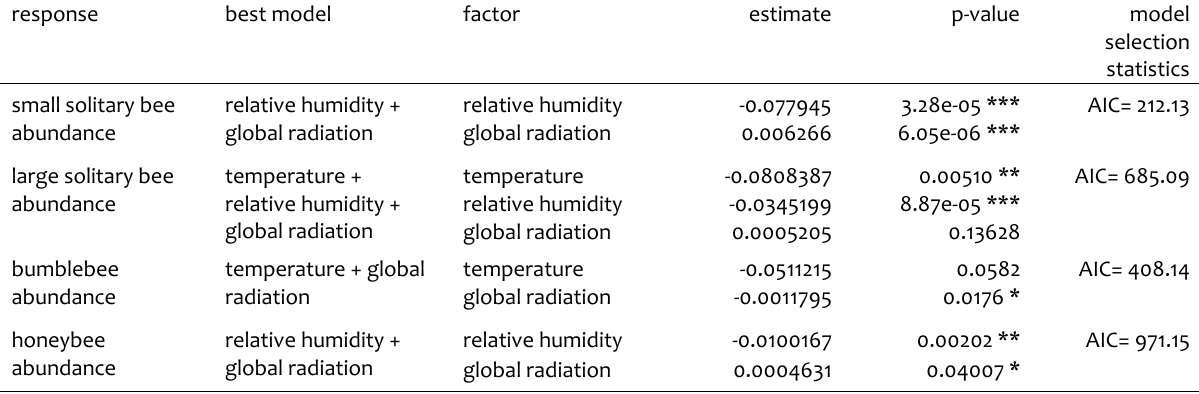
Table 10. Results of poisson regression models assessing the effect of temperature at 2 m elevation, relative humidity, and global radiation on the abundance of different bee groups on fruit trees. Models were selected using the stepAIC function (selection in both directions). Only best models are reported and model estimates, p-value and model selection statistics are given. Significance is marked with * at P  0.05, ** at P  0.01 and *** at P 